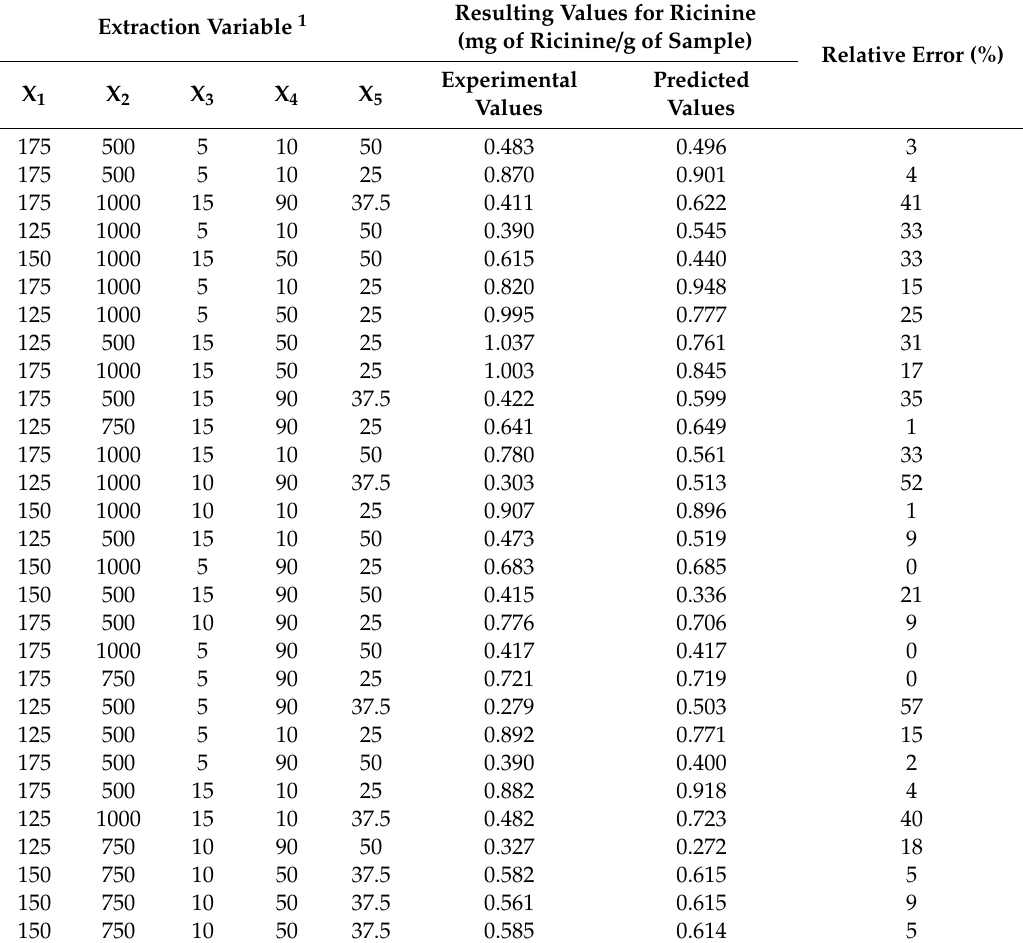
Table 2. Central composite design of five variables with their observed and predicted